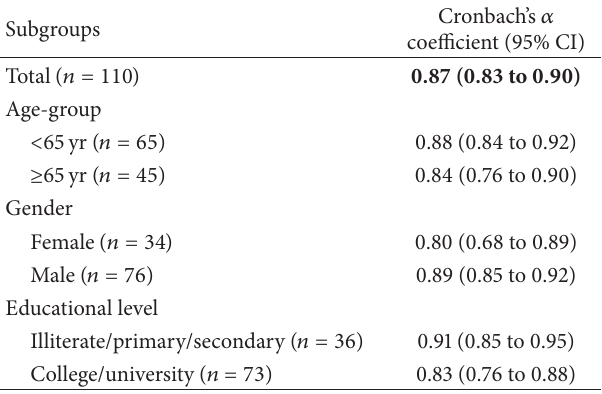
Table 3: Reliability (Cronbach’s 𝛼 ) of the SCOPA-PS questionnaire withinvarioussubgroupsofIranianParkinson’sdiseasepatients (𝑛 = 110)